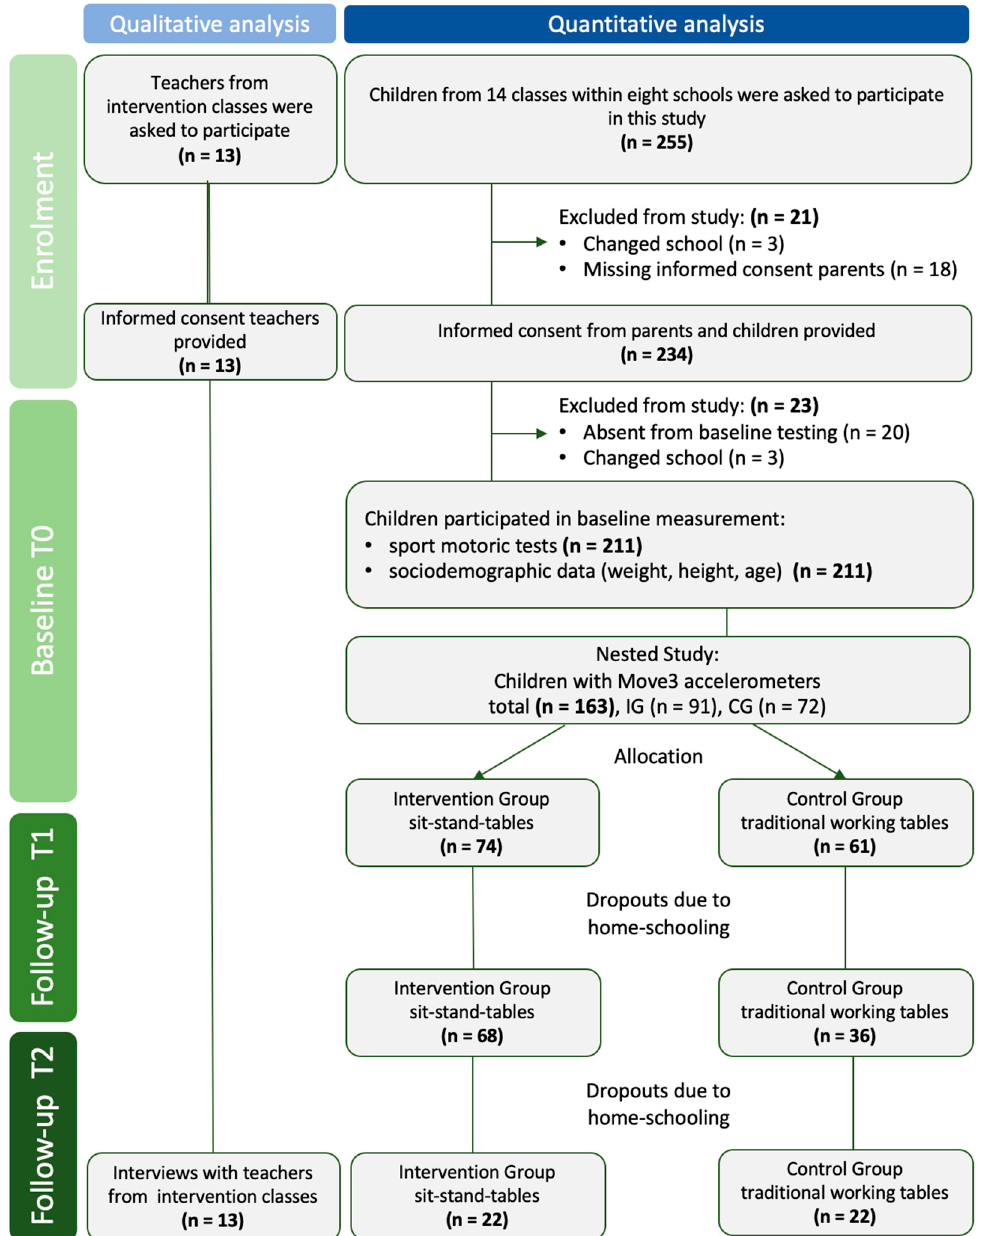
who used sit-stand tables and children who worked at traditional working tables.